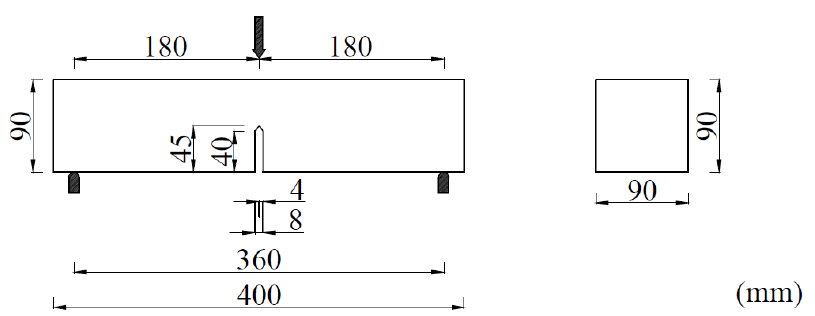
Figure 2. Dimension of specimen and test setup for fracture toughness test.